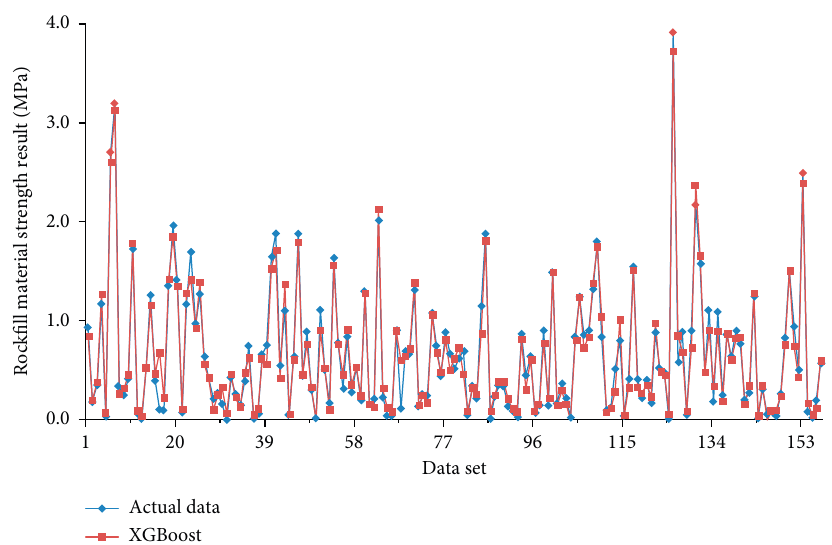
Figure 5: Results of XGBoost model training and testing phases for rockfill material shear strength.